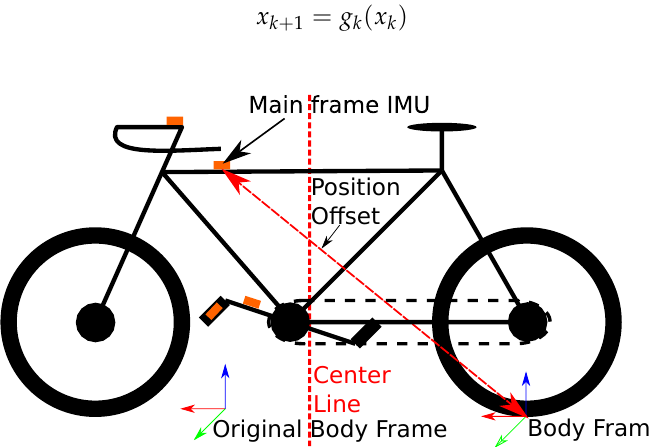
Figure 2. Bike with inertial measurement units (IMUs). Only the main frame IMU is used.